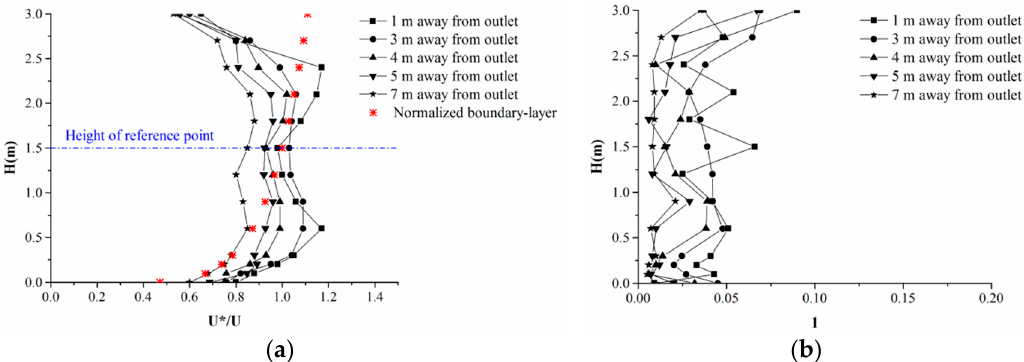
Figure 5. Wind field on the first line of the five sections: ( a ) mean wind and ( b ) turbulence intensity.